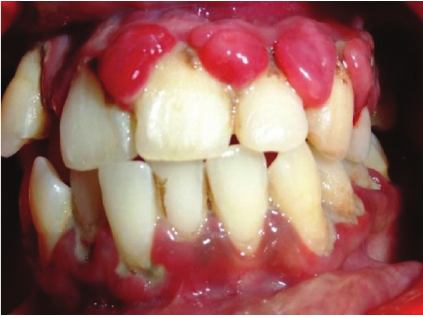
Figure 1: Intraoral view showing unilateral labial overgrowth.